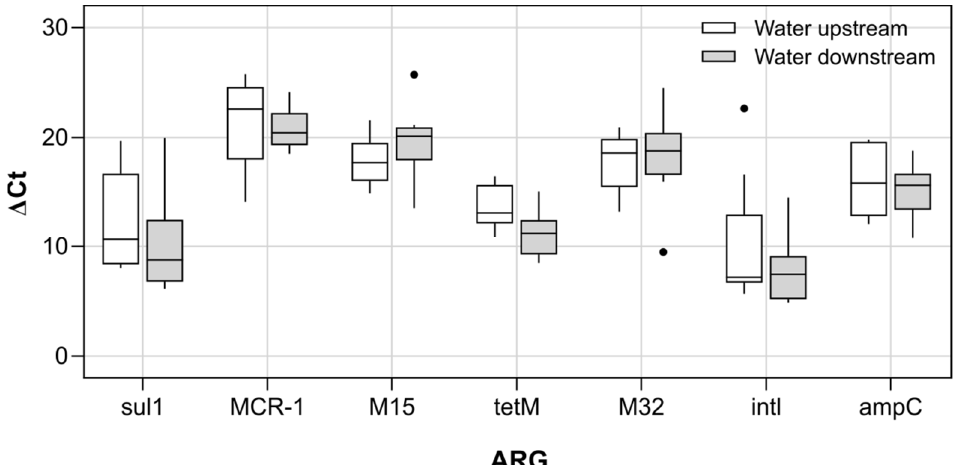
Figure 7. Relative abundance obtained from qPCR Ct values (normalized ARGs copies to 16s rRNA copies) of the seven ARGs analyzed in the surface water taken upstream and downstream of the WWTP analyzed in the surface water taken upstream and downstream of the WWTP. ● indicate data points located outside whiskers of the Tukey's boxplot (outliers)